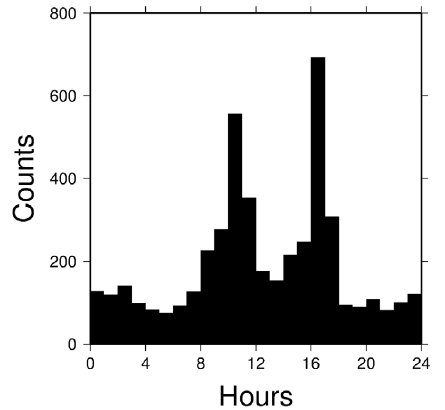
Figure 4. Histogram of the hourly distribution (UTC time = local time – 1) of the seismicity extracted from the most anomalous red areas in Figure 3. It is evident the strong concentration around two peaks, but also the existence of a significant seismicity during the